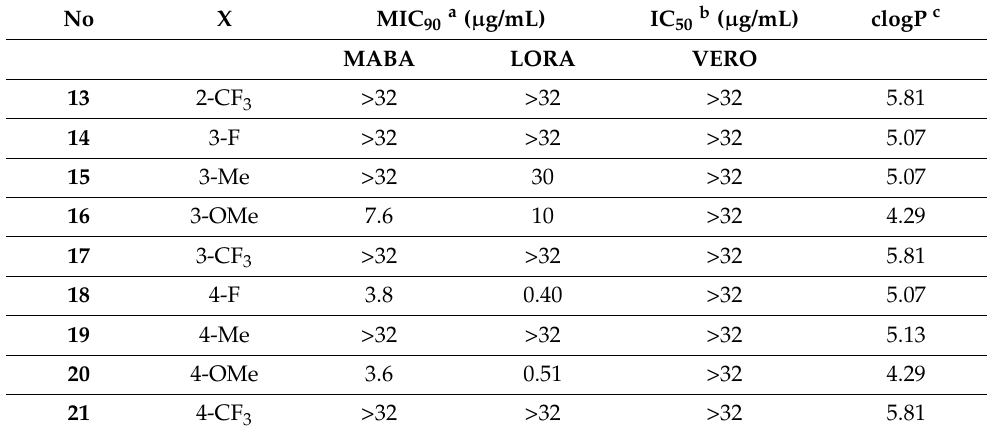
Table 1 a: MIC 90 ( μ g/mL); minimum inhibitory concentration for 90% inhibition of growth of M.tb strain H37Rv, determined under aerobic/replicating (MABA) [19] or non-replicating (LORA) [20] conditions, determined at the Institute for Tuberculosis Research, University of Illinois at Chicago; b IC50 values ( µ g/mL) for the inhibition of growth of VERO green monkey kidney epithelial cells [21]. c clogP values calculated by ChemDraw Ultra v21.0.0.28 (CambridgeSoft). Table 2. Structures and biological data for 5 ‐ substituted 3 ‐ (4 ‐ fluorophenyl) ‐ N ‐ (pyridin ‐ 2 ‐ ylme